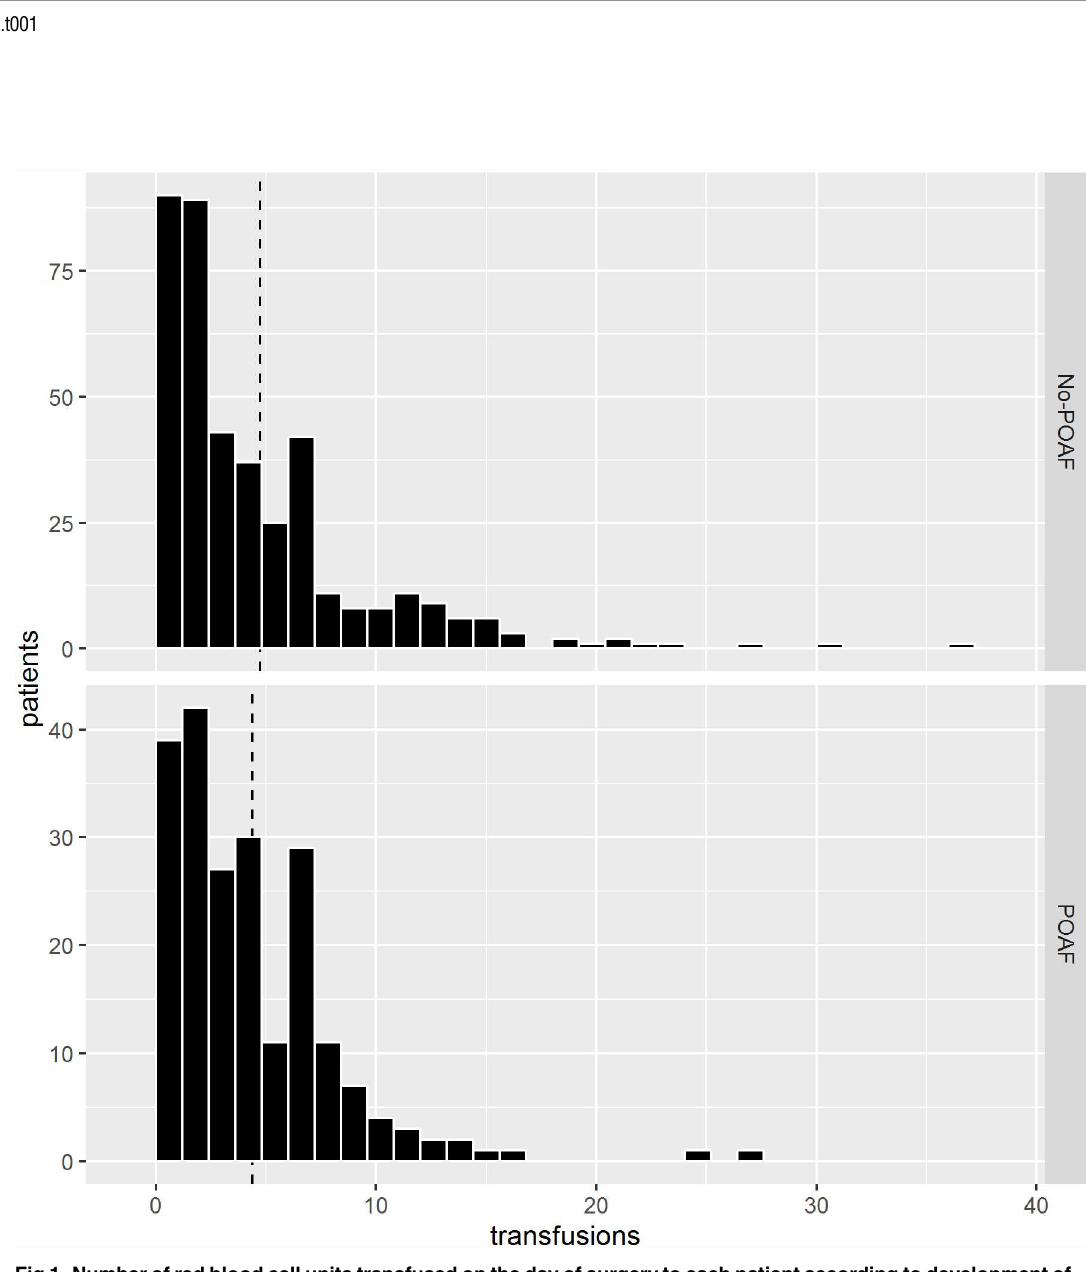
Fig 1. Number of red blood cell units transfused on the day of surgery to each patient according to development of postoperative atrial fibrillation. Dashedline represents the averagenumber of transfused units for each